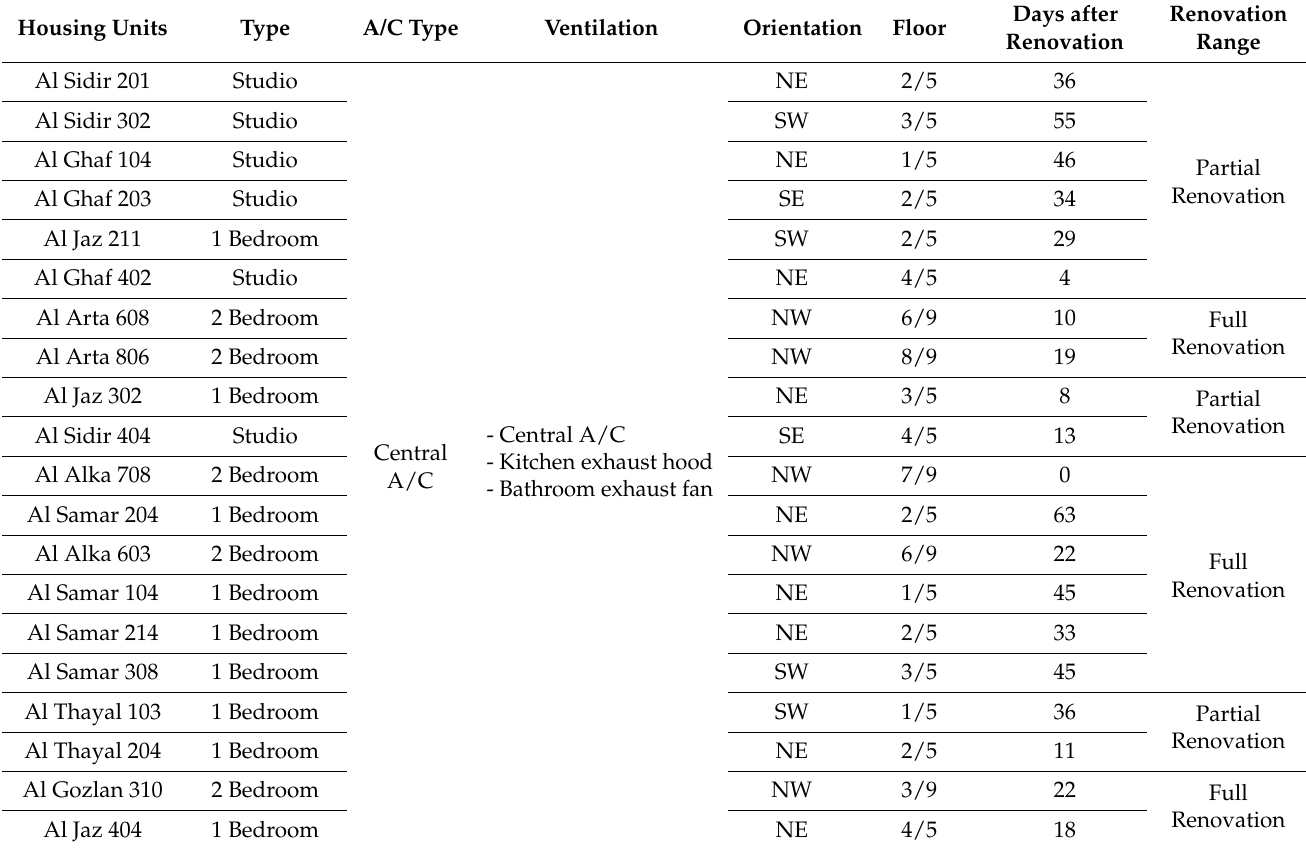
Table 6. Overview of the surveyed housing units in The Greens,